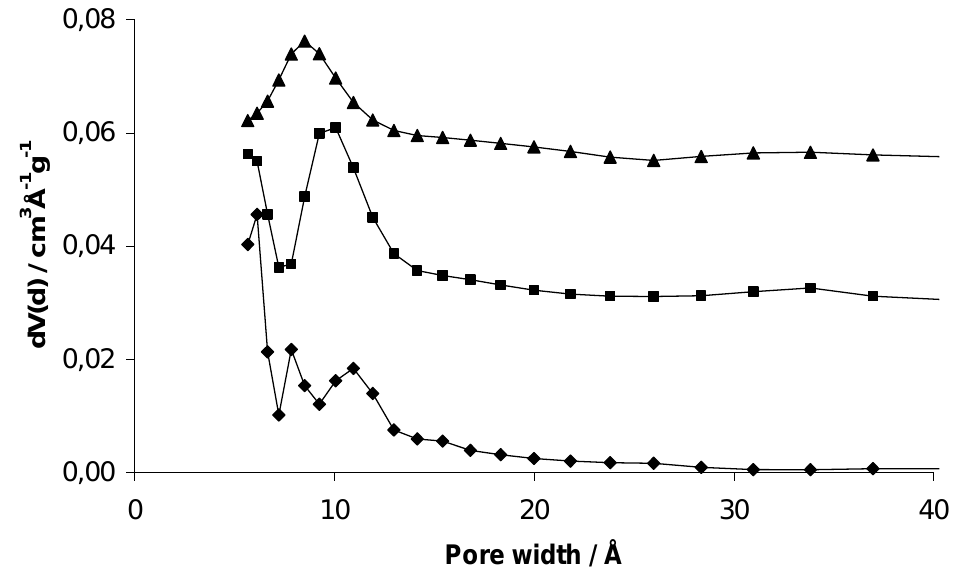
Figure 6. Pore size distribution of EOF-3 (diamonds), -4 (squares, offset: 0.03) and -5 (triangles, offset: 0.055) determined using the quenched solid density functional theory (QSDFT) equilibrium model for nitrogen on carbon at 77 K with slit